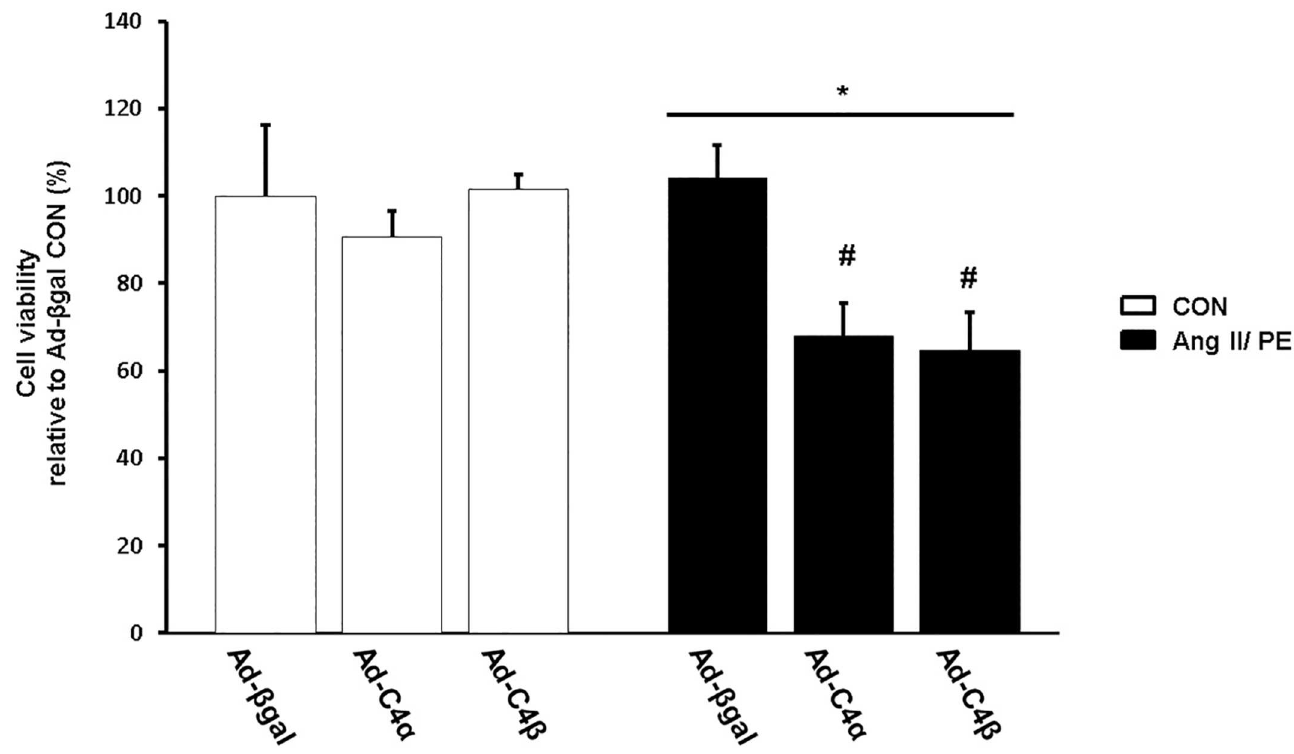
Fig 10. TRPC4 α and TRPC4 β lower cardiomyocyte viability after chronic agonist stimulation. The vitality of cardiomyocytes expressing β gal (Ad- β gal), TRPC4 α (Ad-C4 α )or TRPC4 β (Ad-C4 β ) was determined after angiotensin II/phenylephrine (Ang II/PE) or vehicle(CON) treatment for 24 h by applyingthe trypan blue exclusionassay. The assay was performed in duplicateand averagevalues were quantifiedrelative to Ad- β galCON; n = 3 experiments. * P < 0.05vs Ad-C4 α and Ad-C4 β Ang II/PE. B. # P < 0.05 vs Ad-C4 α and Ad-C4 β CON.